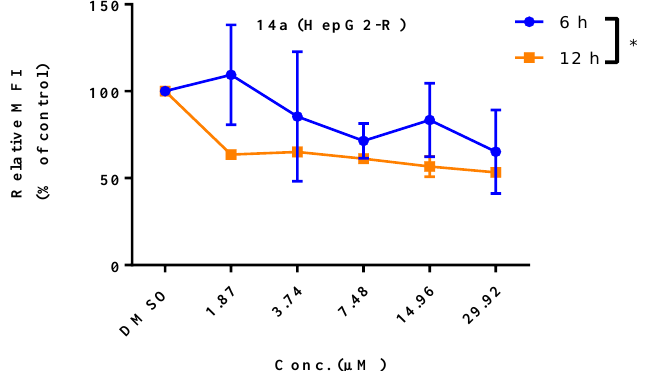
Figure 7. Intracellular NO release of NO- ∆ -16-CIEA 14a in HepG2-R as measured by DAF-FM DA assay. Values reported are averages ± SD of at least two measurements. * p ≤ 0.05.